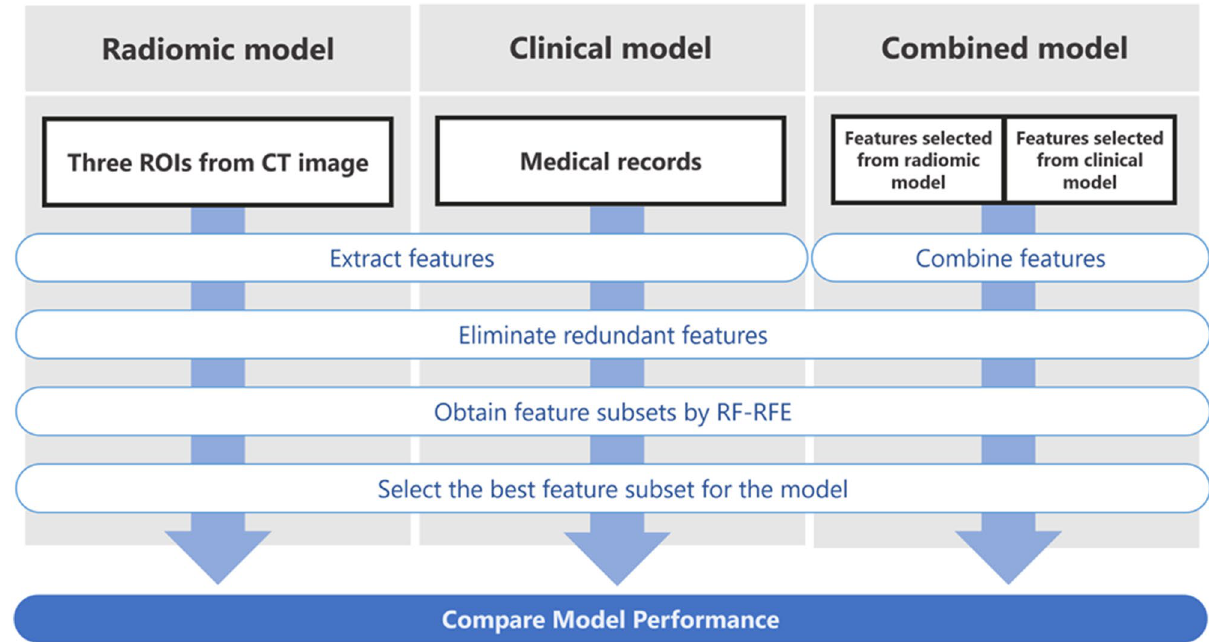
Figure 1. The workflow for our study of radiotherapy-induced pain response in patients with spinal